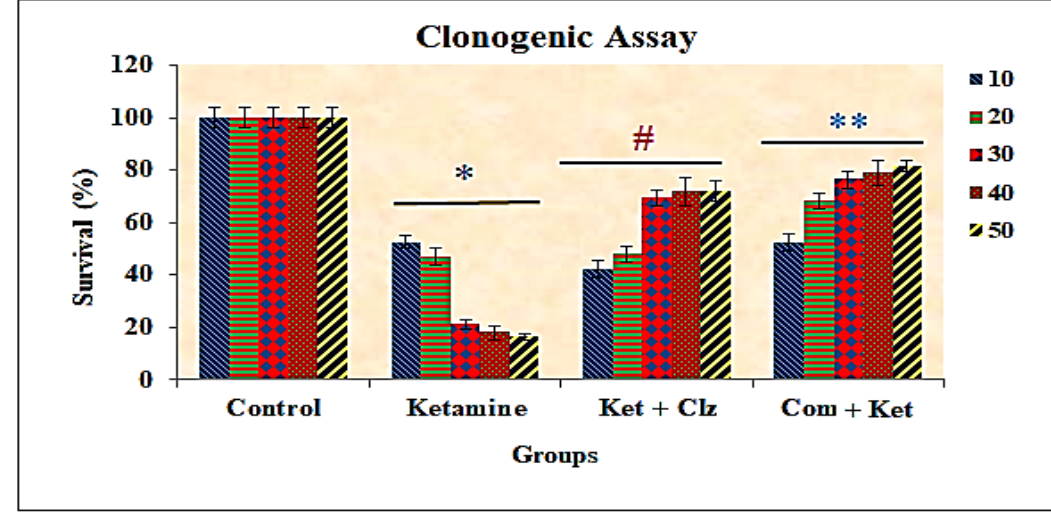
Figure 8. Effects of plant compound and clozapine on clonogenic assay (cell survival ability analysis) of PC 12 cell lines during ketamine induction in vitro. All the values are expressed as means ± SD of six individuals. * Significant at p < 0.05 compared with control; # and ** significant at p < 0.05 compared with the ketamine treated group; 10 – 50: concentration in µg/mL of ketamine, clozapine, and compound. 3.6. Semi-Quantitative RT-PCR Analysis RNA extraction was carried out using a single step with TRIzol reagent (Invitrogen). The total RNA extracted from cell culture was subjected to cDNA synthesis by reverse transcriptase enzyme (M-MuLV) using a specific set of primers for amplification of dopa- minergic genes. Denaturation at 95 °C for 5 min and cDNA synthesis at 42 °C for 90 min showed good amplification on PCR. In addition, 35 cycles of PCR with an annealing tem- perature of 49 °C at a 1.5 mM concentration of MgCl 2 was found to be optimum for the amplification of DOPA genes. The size of the amplified products of DOPA genes such as TH (222 bp), DDC (81bp), DBH (606bp), and VMAT2 (326bp) was analyzed by agarose gel electrophoresis by employing a standard DNA molecular size marker (Fermentas 1 Kb